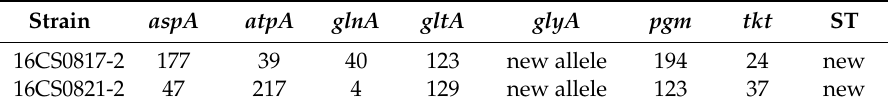
Table 4. Results of the multilocus sequence typing (MLST). Allelic profiles of the A. butzleri isolates 16CS0817-2 and 16CS0821-2.